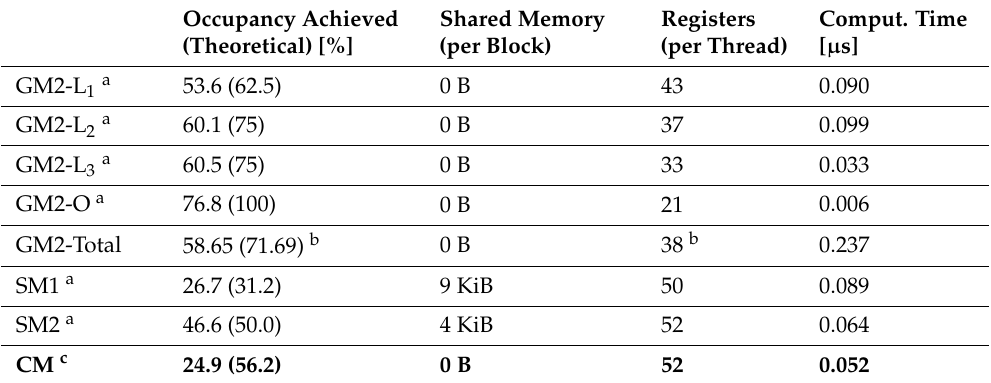
Table 4. Inference on GPU: GM2, SM1, SM2 and CM implementations for a batch of 512 NNs with a {16, 32|16|8, 4} topology.